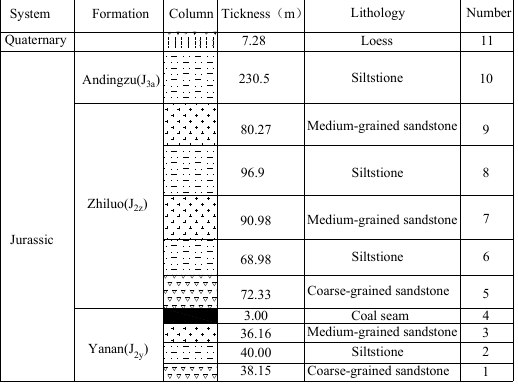
Figure 5. Strata histogram.